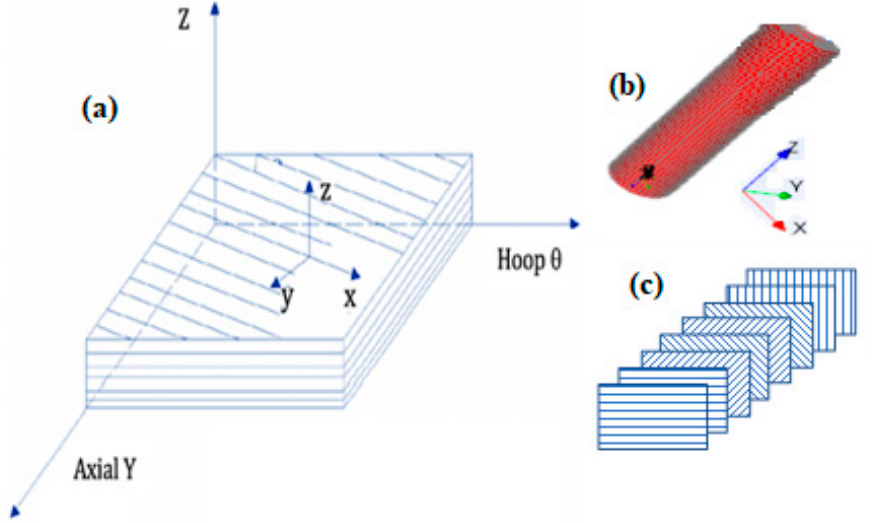
Figure 8. Illustrations of composite laminae showing ( a ) axial cum hoop directions, ( b ) the compo- site tubular and ( c ) its lay-up.